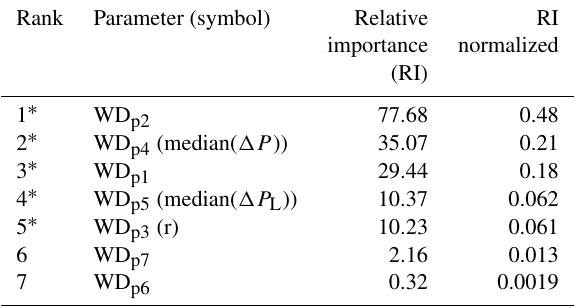
Table 3. Wet–dry classification sensitivity analysis: WD p n (sym- bol) – wet–dry classification parameters; see description in Table